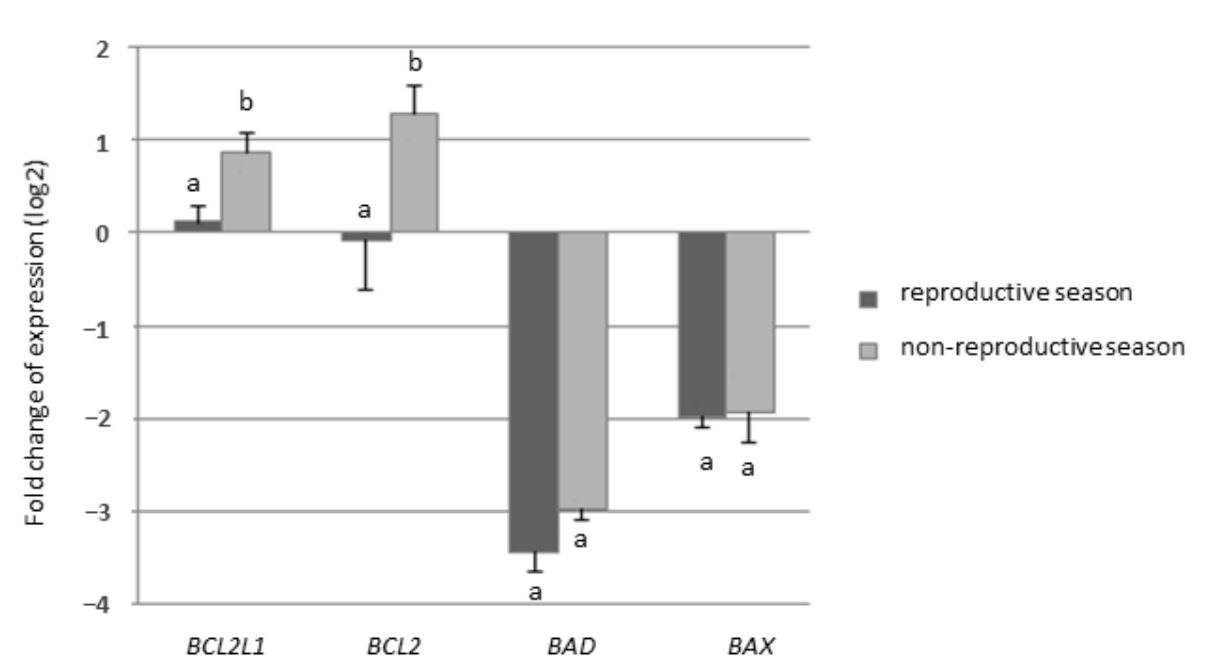
Figure 2. Results of Experiment I. Relative gene expression of antiapoptotic ( BCL2L1, BCL2 ) and proapoptotic ( BAX, BAD ) genes in testicular tissue collected during the reproductive and non-reproductive season. a, b: different lowercase letters indicate significant differences ( p < 0.05). Data presented as mean values ± SEM.